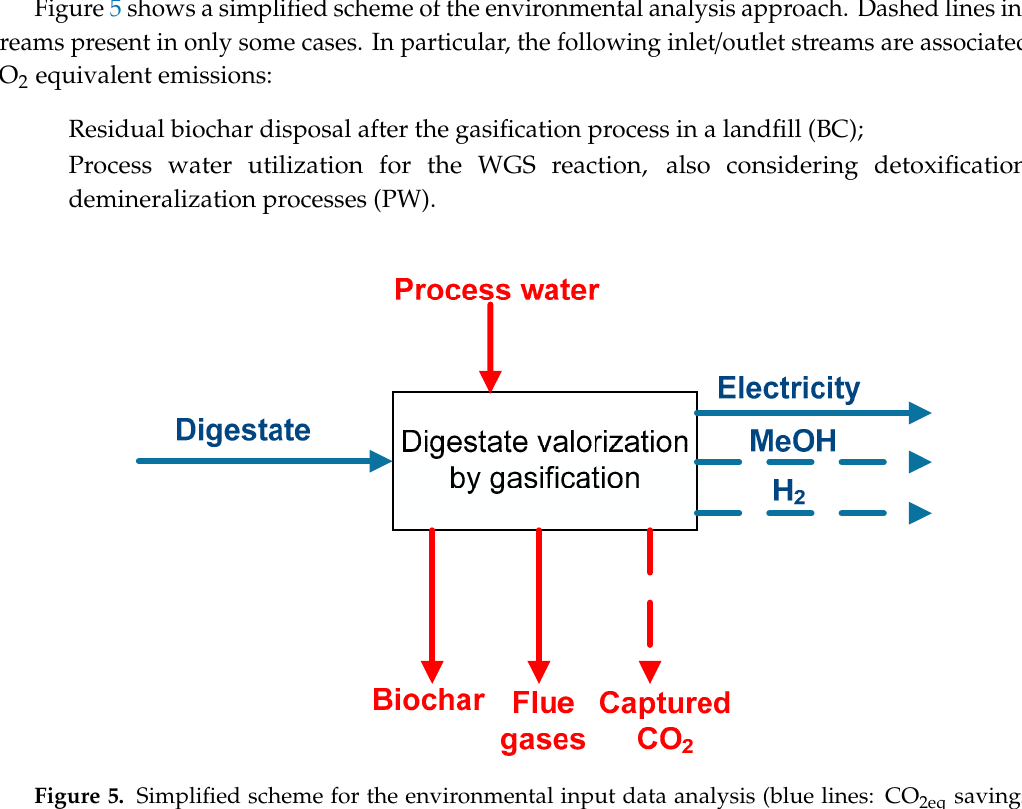
Figure 4. Flowsheet of valorization of digestate for producing hydrogen.